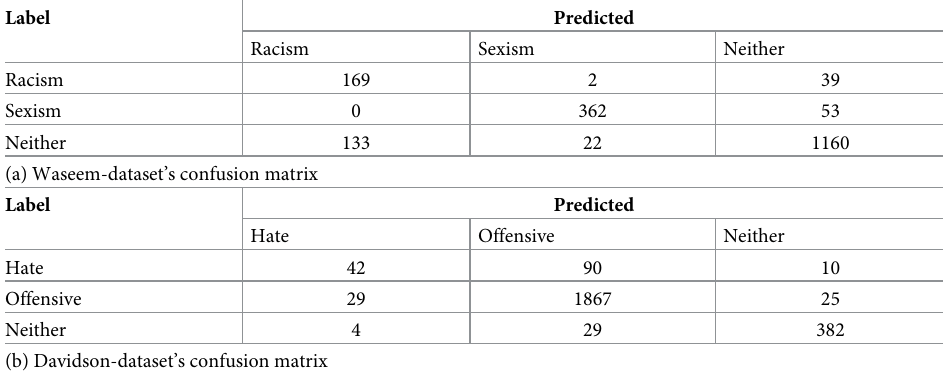
Table 3. Confusion matrix of the both Waseem-dataset (a) and Davidson-dataset (b). Label Predicted Racism